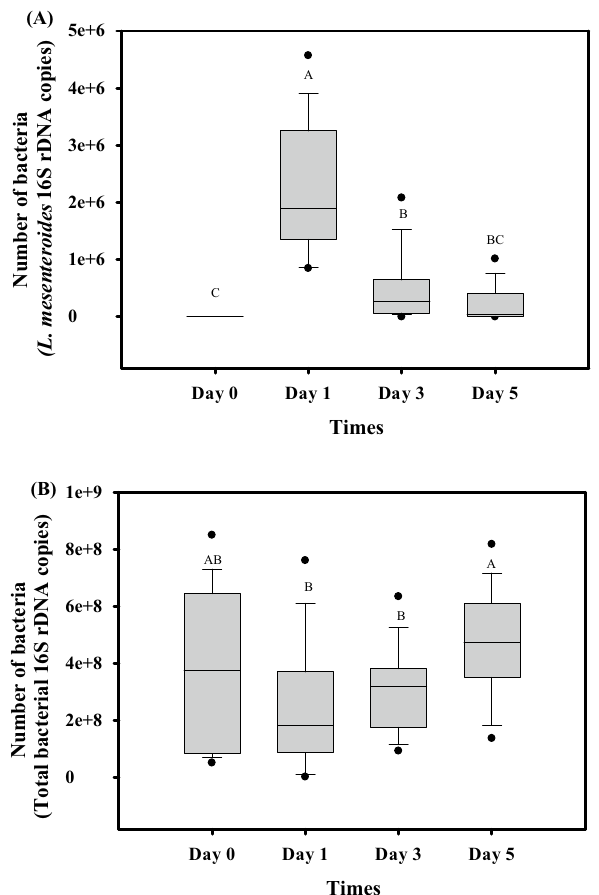
Figure 4. Evaluation of Leuconostoc mesenteroides TBE-8 transmission in a four-frame colony. ( A ) The bacterial loads of TBE-8 were assessed through quantitative polymerase chain reaction (qPCR) by using a specific L. mesenteroides TaqMan probe. ( B ) Total bacterial loads were assessed through qPCR by using universal bacterial 16S rDNA primers. Gut DNA samples from Day 0 (before feeding) and Days 1, 3, and 5 (after feeding) were prepared for qPCR. At each time point, a total of 16 samples from two bee colonies were analyzed. The box plot displays low, first quartile, median, third quartile, and high values, respectively. The letters A, B, C, AB and BC indicate statistically significant difference ( P < 0.0001) according to the least significant